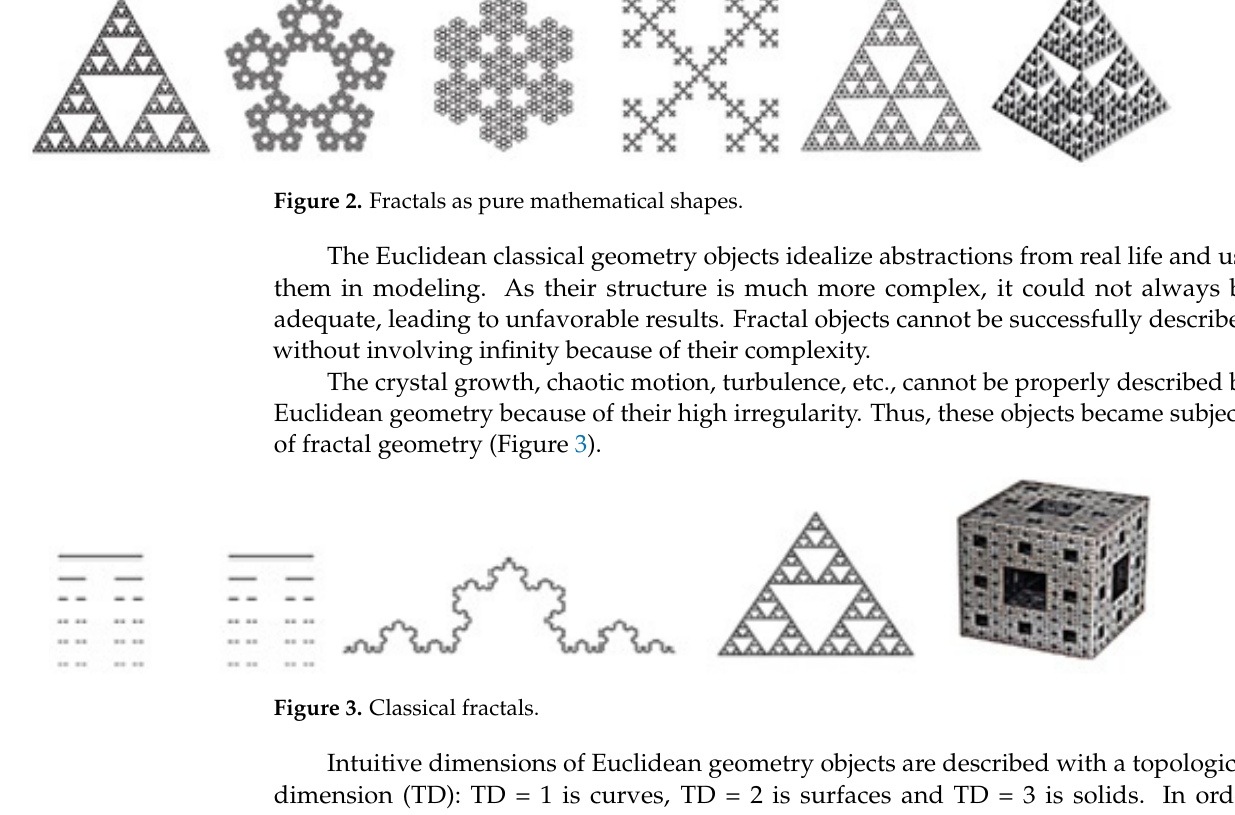
Figure 4. Grain structure reconstruction using fractal interpolation.